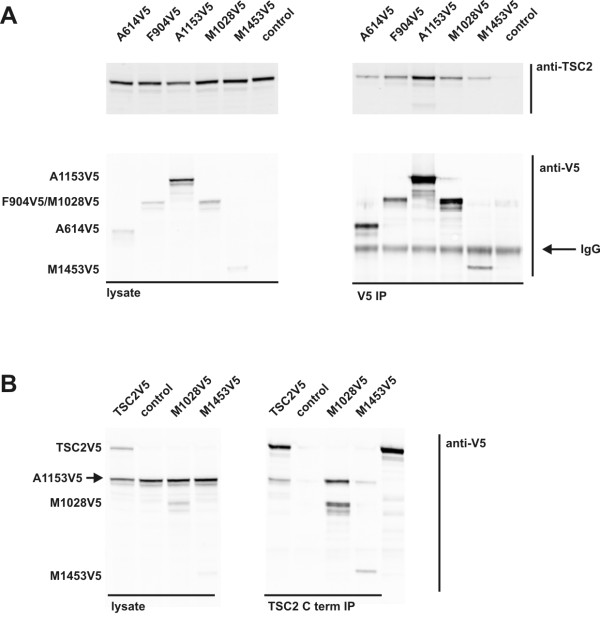
Coimmunoprecipitation analysis of TSC2-TSC2 interactions using truncated TSC2 proteins. A series of V5-tagged TSC2 truncation proteins were coexpressed with TSC2, or in combination. The truncated proteins were immunoprecipitated and coimmunoprecipitated proteins detected by immunoblotting. (A) Coimmunoprecipitation of untagged, full-length TSC2 with TSC2 truncation proteins. The V5-tagged truncated TSC2 proteins (A614V5, F904V5, A1153V5, M1028V5 and M1453V5; see Materials and Methods and Suppl. Figure 1. for details) were immunoprecipitated with anti-V5 affinity beads and the washed immunoprecipitates were analysed by immunoblotting. TSC2 was coimmunoprecipitated with all 5 TSC2 truncation proteins, but was not visible in the control transfection (control; no V5-tagged protein expressed). (B) Coimmunoprecipitation of the A1153V5 TSC2 truncation protein with untagged TSC2 and the N-terminal TSC2 truncation proteins, M1028V5 and M1453V5. Full-length TSC2 and the M1028V5 and M1453V5 truncation proteins were immunoprecipitated with a polyclonal antibody recognising epitopes encoded by the last exon of TSC2 [5] and the washed immunoprecipitates were analysed by immunoblotting. In each case, the A1153V5 truncation protein was coimmunoprecipitated. No A1153V5 was visible in the immunoprecipitate of control cells, expressing A1153V5 only (control).